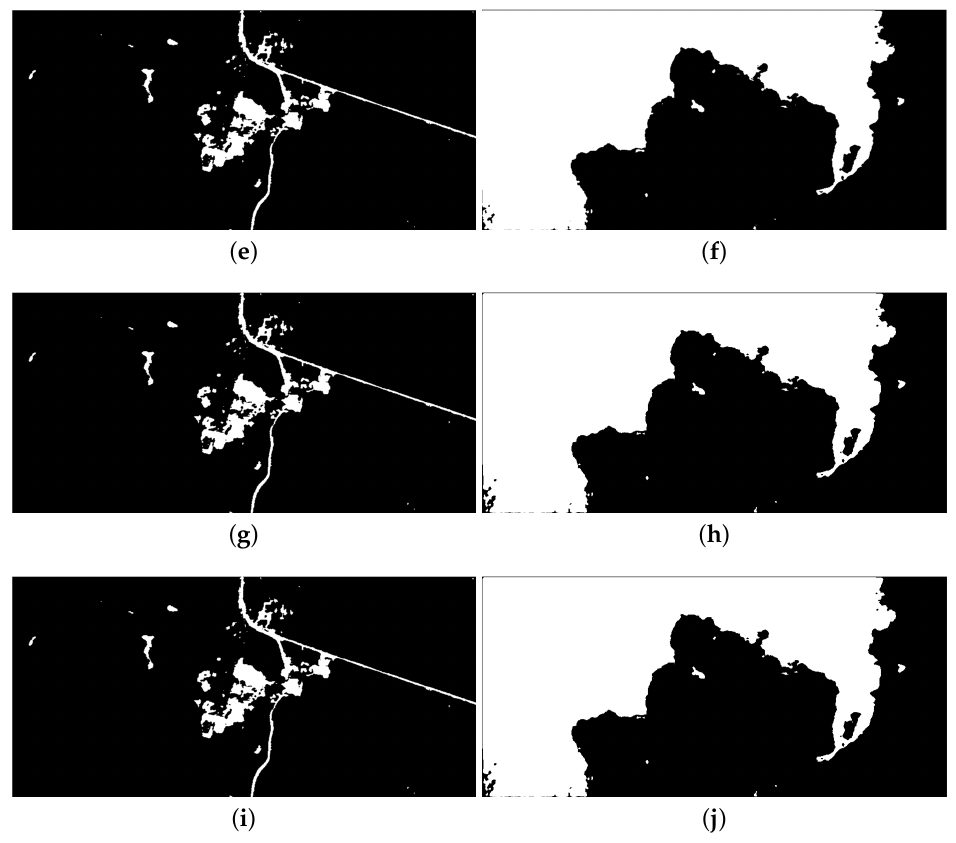
Figure 9. Original images and segmentation results: taken by the IKONOS satellite. ( a ) Original image of Uxmal; ( b ) Original image of volcano; ( c ) cpu_m segmentation of Uxmal; ( d ) cpu_m segmentation of volcano; ( e ) cpu_c segmentation of Uxmal; ( f ) cpu_c segmentation of volcano; ( g ) fpga_hls_ori segmentation of Uxmal; ( h ) fpga_hls_ori segmentation of volcano; ( i ) fpga_hls_opt segmentation of Uxmal; ( j ) fpga_hls_opt segmentation of volcano.